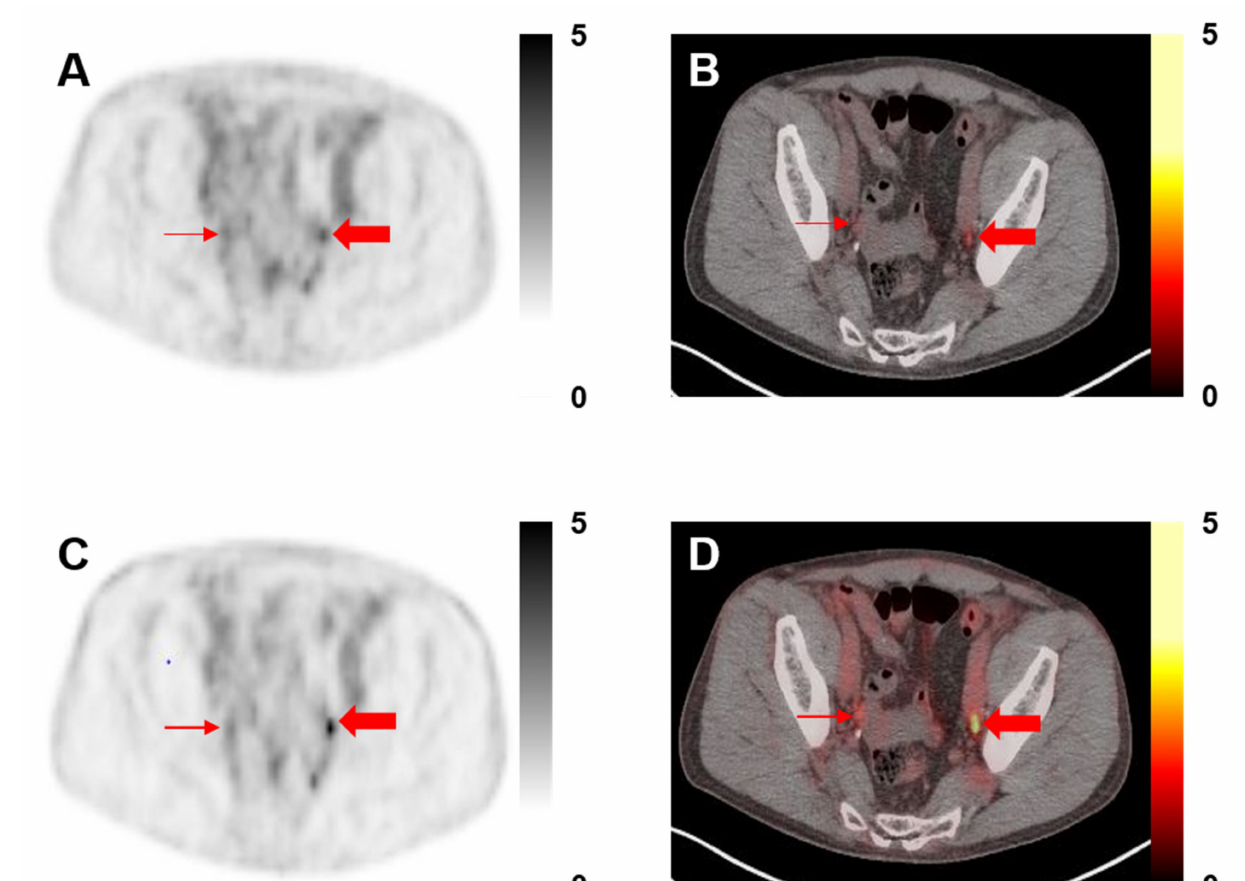
Figure 1. A 68-year-old man with history of prostatectomy and adjuvant chemohormonal therapy, now with an increase in prostate-specific antigen (PSA) to 0.3. ( A ) 18 F-DCFPyL positron emission tomography (PET) and ( B ) PET/computed tomography (CT) axial images without point-spread function (PSF) demonstrating bilateral PSMA-RADS-3A pelvic lymph nodes (thin and thick red arrows, maximum standardized uptake value (SUV max ) 1.2 on the right and 1.5 on the left). ( C ) 18 F-DCFPyL PET and ( D ) PET/CT axial images with PSF show that the right pelvic PSMA-RADS-3A lymph node does not appear significantly more conspicuous (SUV max 2.2) and that lesion was not re-categorized. However, the lymph node on the left (SUV max 2.5) was thought to be more conspicuous and was re-categorized to